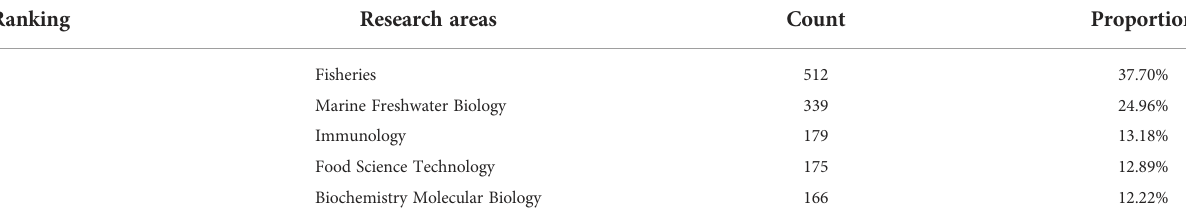
TABLE 5 Classi fi cation of the main research areas of Apostichopus japonicus based on the subject classi fi cation method of Web of Science (WoS) from 2000 to 2021.